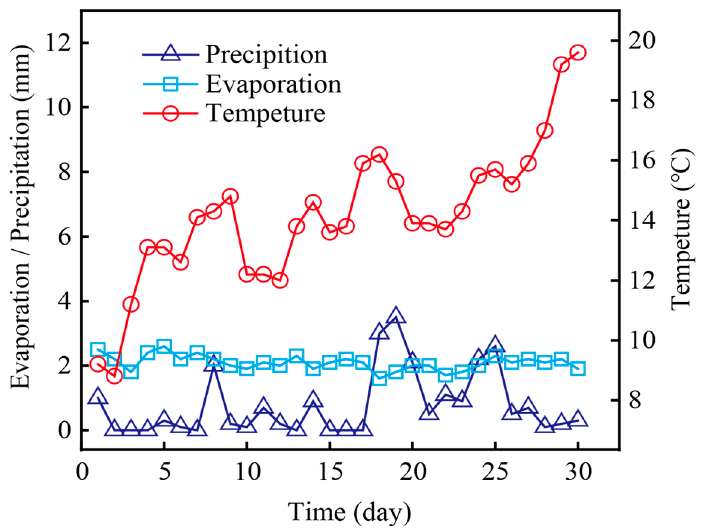
Figure 2. Precipitation, evaporation, and temperature in April in study site.